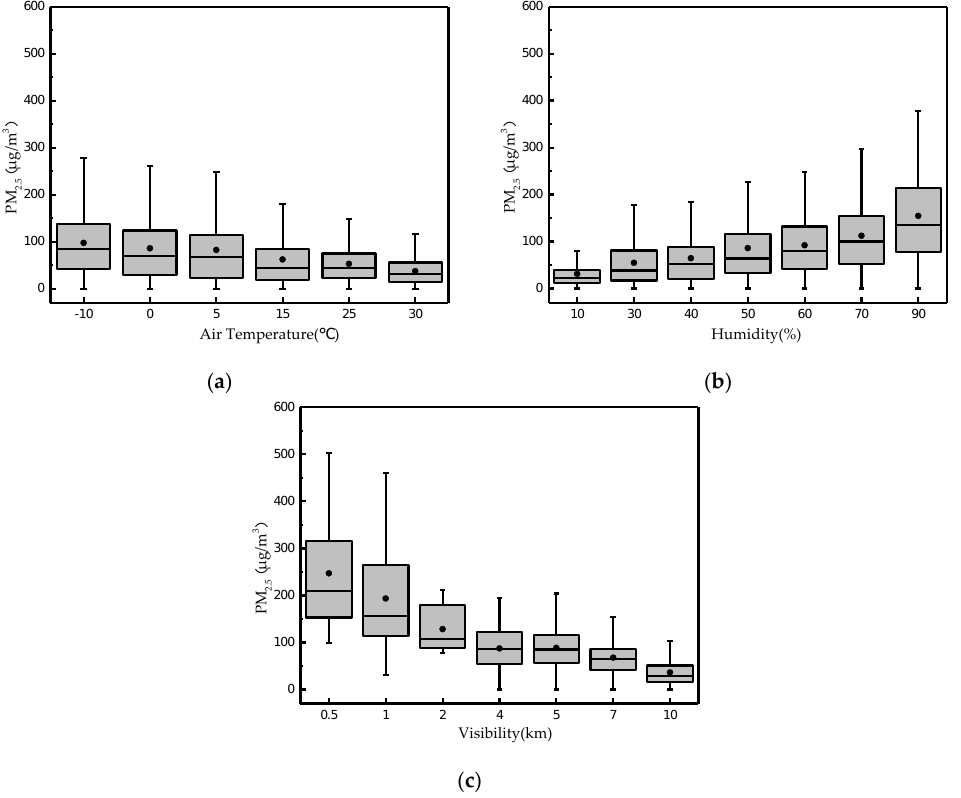
Figure 4. Box charts of meteorological features and fine particulate matter (PM 2.5 ) concentration: ( a ) air temperature; ( b ) humidity; ( c ) visibility.